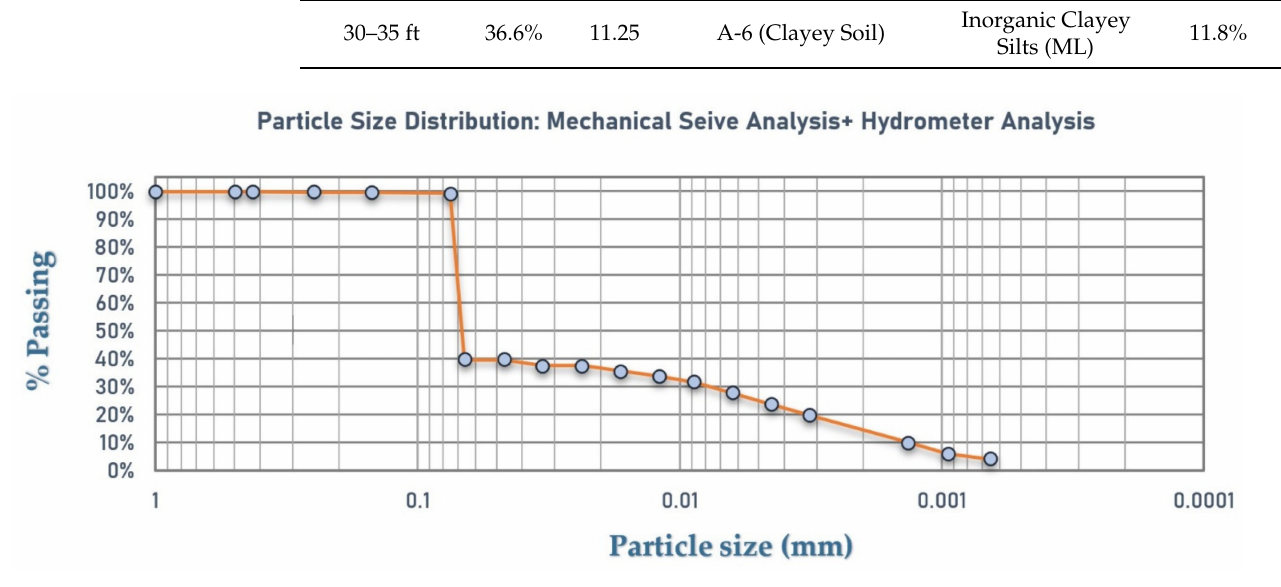
Figure 4. Particle size distribution curve.